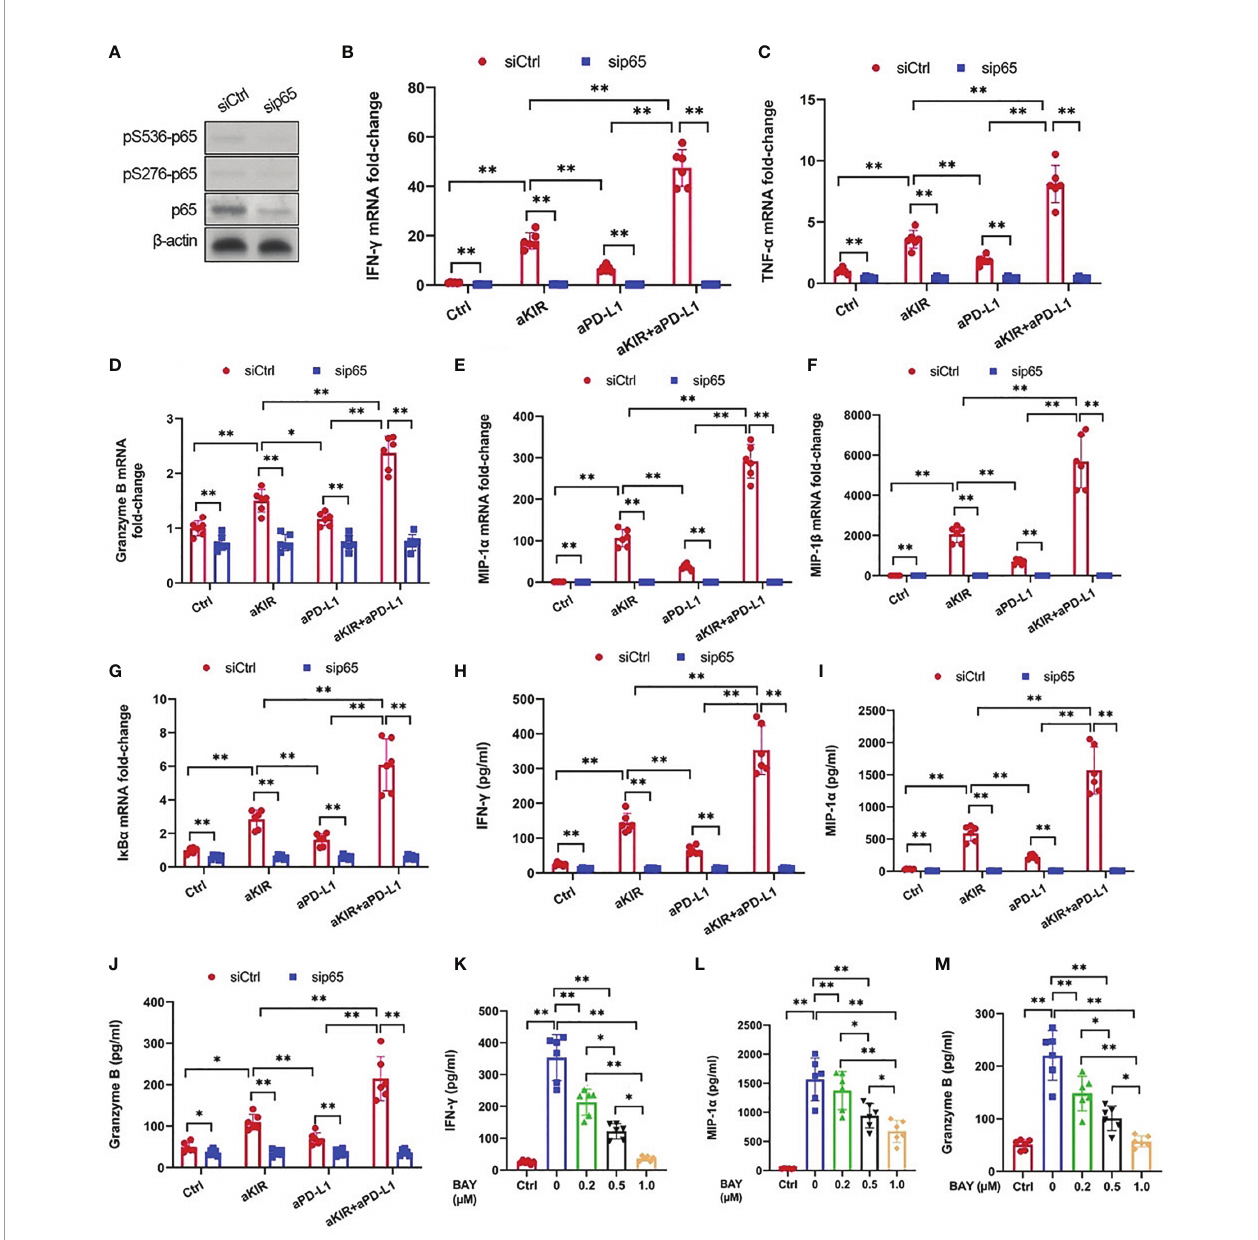
FIGURE 4 | Lirilumab and Avelumab Co-Engagement Upregulates Cytokine and Granzyme B Expression in a NF- k B-Dependent Manner. (A) NK cells were transfected with 300 pmol control siRNA (siCtrl) or anti-p65 siRNA (sip65) for 24 h. Cells were rested for another 24 h, and lysates were immunoblotted for p65 and b -actin. (B-G) IL-2-primed NK cells transfected with siCtrl or sip65 were mixed with autologous target cells and stimulated with aKIR and/or aPD-L1 for 3 h. Relative mRNA levels of (B) IFN- g , (C) TNF- a , (D) granzyme B, (E) MIP-1 a , (F) MIP-1 b , and (G) I k B a were determined by real-time PCR and normalized to b -actin mRNA expression. (H-J) Transfected IL-2-primed NK cells were mixed with autologous target cells and stimulated as in (B-G) for (H, I) 8 h or (J) 2 h. (H) IFN- g , (I) MIP-1 a , and (J) Granzyme B were measured by ELISA. (K – M) IL-2-primed NK cells were pretreated with the NF-kB inhibitor BAY11-7082 (BAY) at the indicated doses for 1 h, mixed with autologous target cells, and stimulated with both aKIR and aPD-L1 for (K, L) 8 h or (M) 2 h. (K) IFN- g , (L) MIP-1 a , and (M) Granzyme B were measured by ELISA. * P < 0.05, ** P < 0.01 [ (B – J) two-way ANOVA (mAb factor × transfection factor), (K – M) one-way ANOVA]. n= 3 biological replicates×3 technical